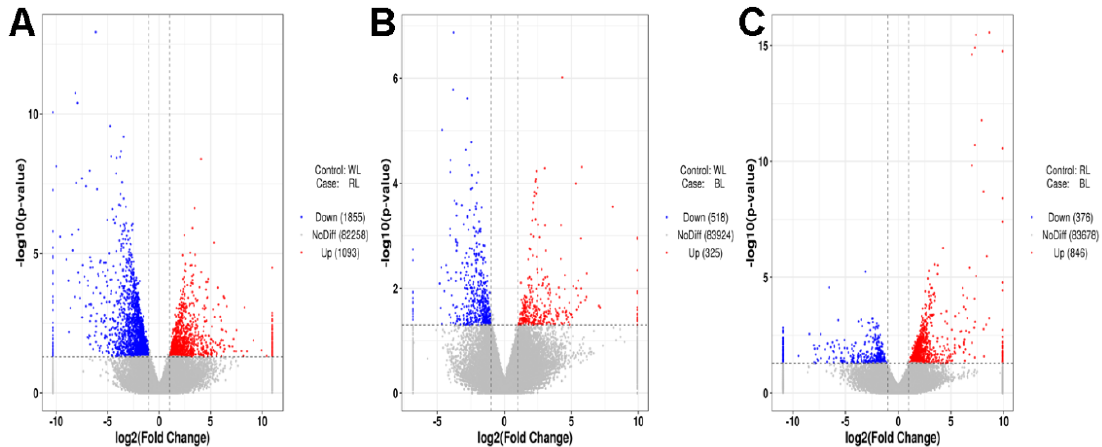
Figure 3. Differentially expressed gene analysis of C. oleifera leaves under different light conditions. ( A ) Differentially expressed genes in WL vs. RL. WL represents leaf tissue growth under white light conditions; RL represents leaf tissue growth under red light conditions. ( B ) Differentially expressed genes in WL vs. BL. BL represents leaf tissue growth under blue light conditions. ( C ) Differentially expressed genes in RL vs. BL. In these plots, log2(Fold Change) were plotted against the –log10( p -value). Genes with p -value < 0.05 and fold changes above 1.0 were considered to be upregulated genes, which are shown in red. Genes with p -value < 0.05 and fold changes below −1.0 were considered to be downregulated genes, which are shown in blue. These genes in grey did not show differential expressions.